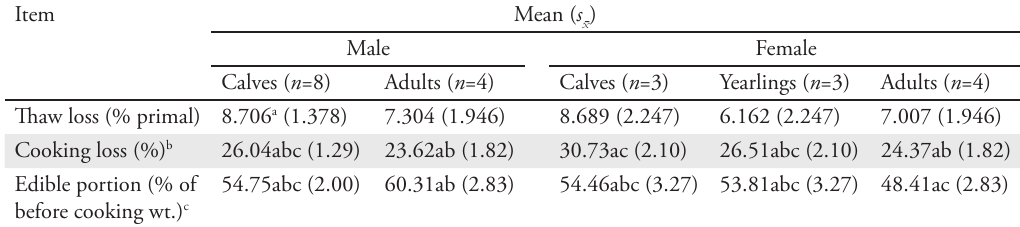
Table 3. Mean (standard error of the mean, s ) physical characteristics of loin steaks of free-ranging reindeer slaugh- x - tered on Nunivak Island, Alaska, January,